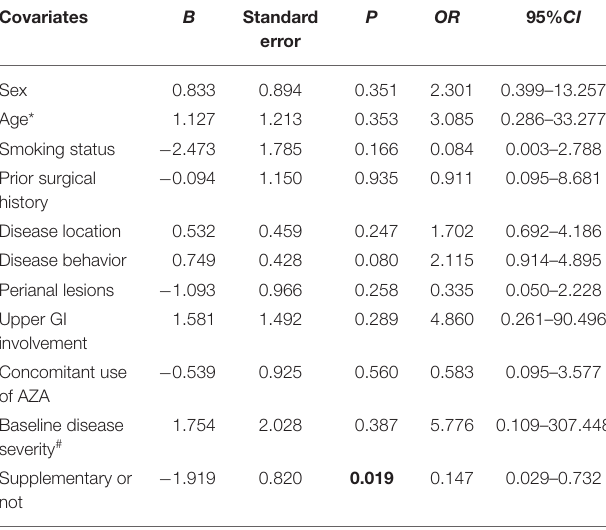
TABLE 3 | The influence of vitamin D3 supplementation on the clinical remission in CD patients treated with IFX (logic regression, enter) ( n = 73). Covariants